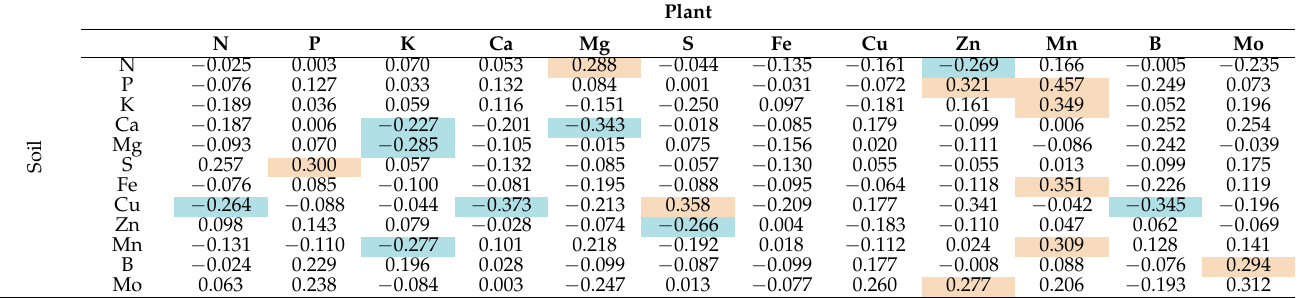
Table 5. Pearson’s correlation coefficients between nutrient concentrations in soil and cloudberry leaves in Latvia.